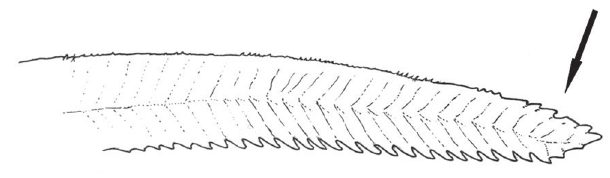
Fig. 3. Pectoral-fin spine (7.1 mm) of Corydoras lymnades , NUP 9965, 28.0 mm SL, showing the serrations in inner margin of the right spine. The arrow indicates the serration in outer margin of the spine distal portion, present in some specimens.